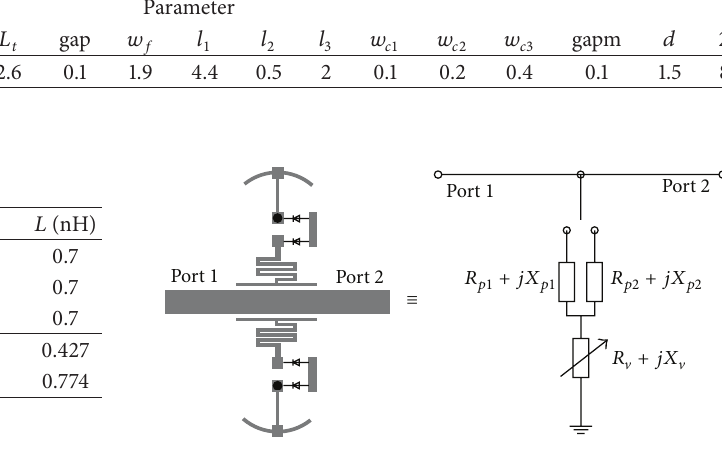
Figure 3: Equivalent circuit of the band-notched structure.